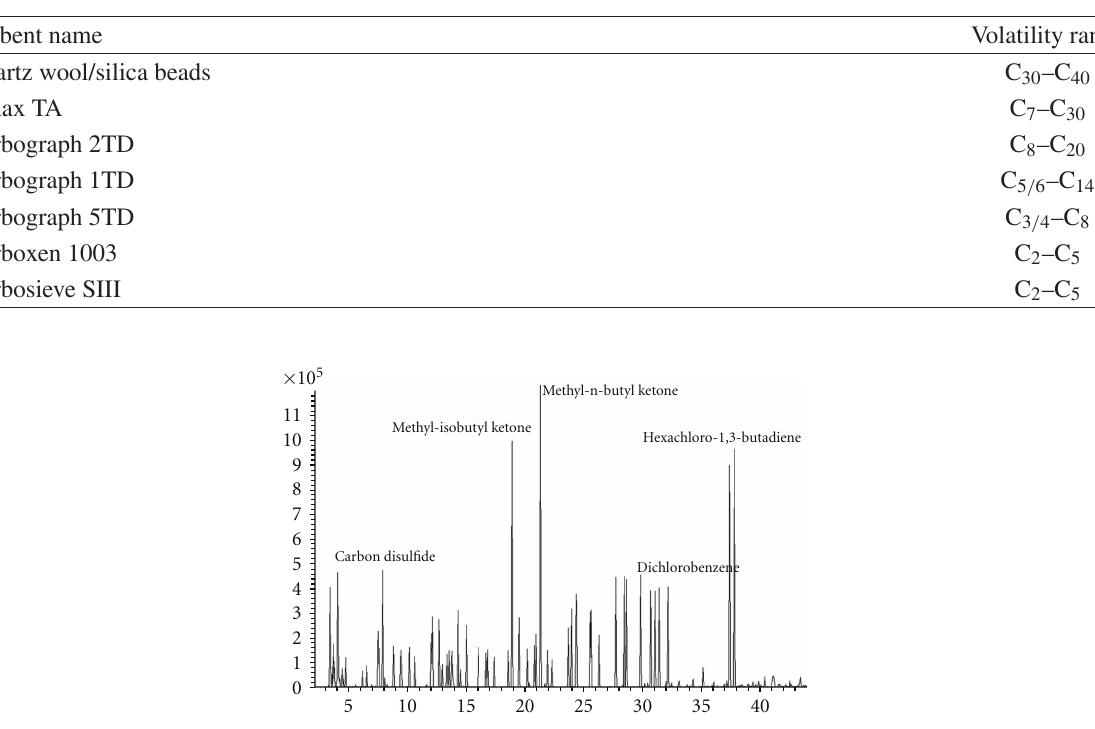
TABLE 6: Popular sorbents and their respective volatility ranges.